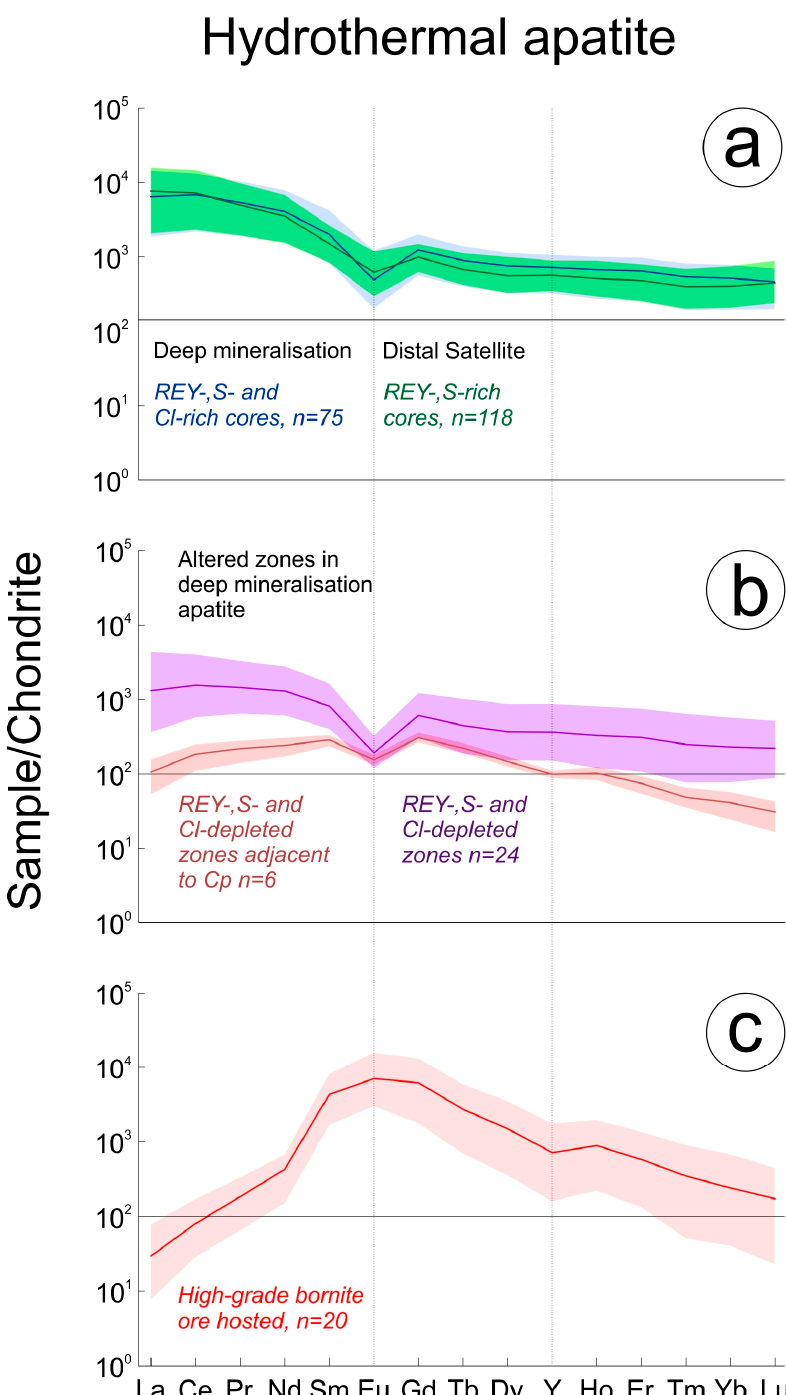
Figure 5. Chondrite-normalized [44] LA-ICP-MS plots of hydrothermal apatite. Analyses were performed on multiple grains hosted within samples listed in the captions to the respective tables. ( a ) Hydrothermal apatite hosted in the Deep and Distal Satellite Mineralization. ( b ) Altered zones in Deep Mineralization hosted apatite related. ( c ) Apatite hosted within the high-grade bornite ore.